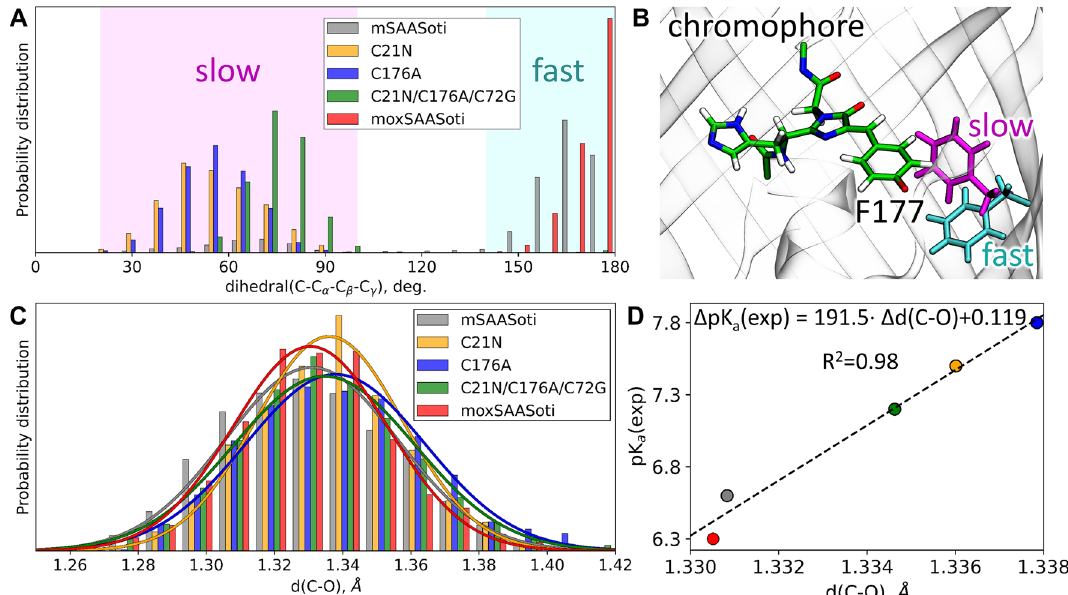
Figure 5. ( A ) Distributions of the C–C α –C β –C γ dihedral of Phe177 in mSAASoti, its C21N, C175A and mSAASoti-3C mutants and moxSAASoti-T. ( B ) For the chromophore and two different conformations of the F177 residue, the conformation colored cyan corresponds to faster off-to-on isomerization and magenta corresponds to slower off-to-on isomerization. The images were drawn in program VMD 1.9.3 (https:// www. ks. uiuc. edu/ Resea rch/ vmd/ vmd-1. 9.3/). ( C ) Distributions of the C–O bond distances in the phenyl fragment of the neutral red form of the chromophore for different mSAASoti variants. ( D ) The relation between the calculated shifts of the mean values of d (C–O) and experimental pK a shifts relative to the mSAASoti